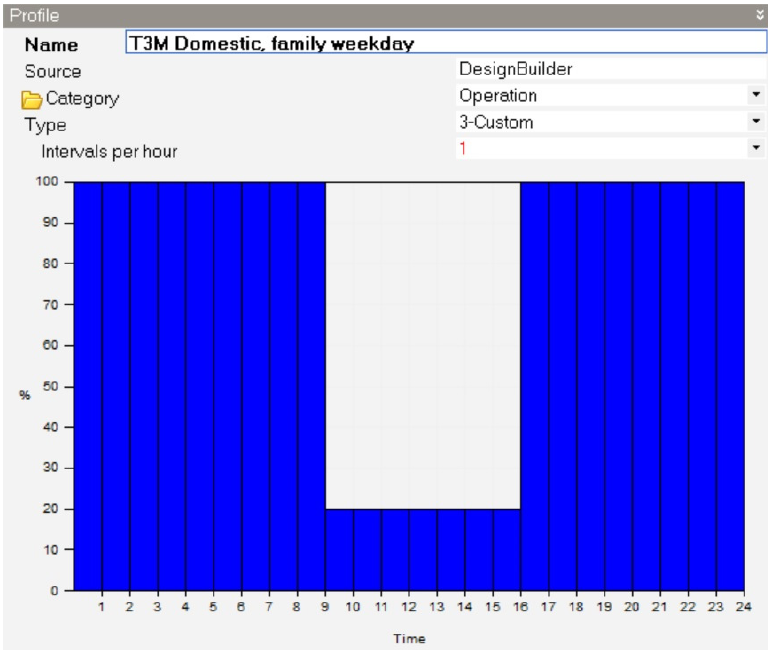
Figure 5. A typical Bahraini family’s daily profile on weekdays, including HVAC and lighting loads.